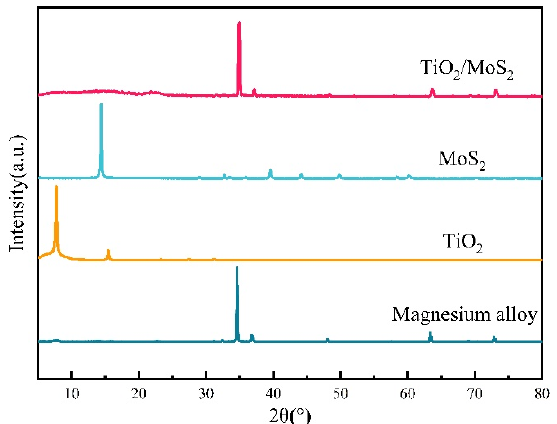
Figure 3. XRD patterns of magnesium alloy, TiO 2 , MoS 2 , and TiO 2 /MoS 2 films.